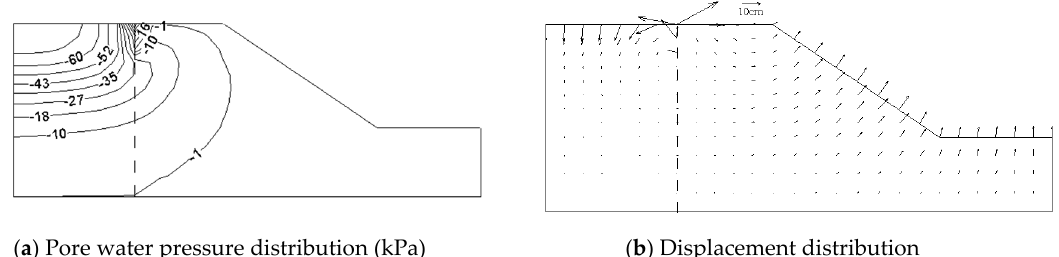
Figure 18. The distributions of pore water pressure and displacement at the end of rainfall under the condition of 1 kPa tensile strength.